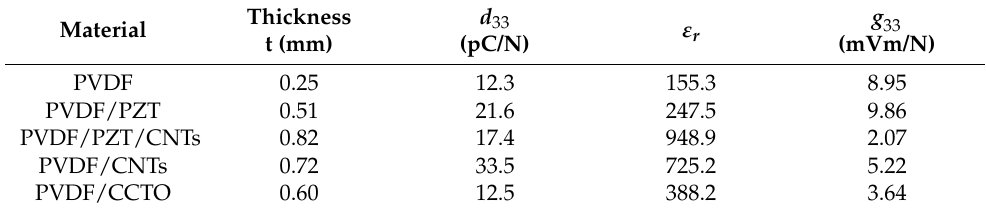
Table 2. Piezoelectric and dielectric properties measurements for the different piezocomposites.